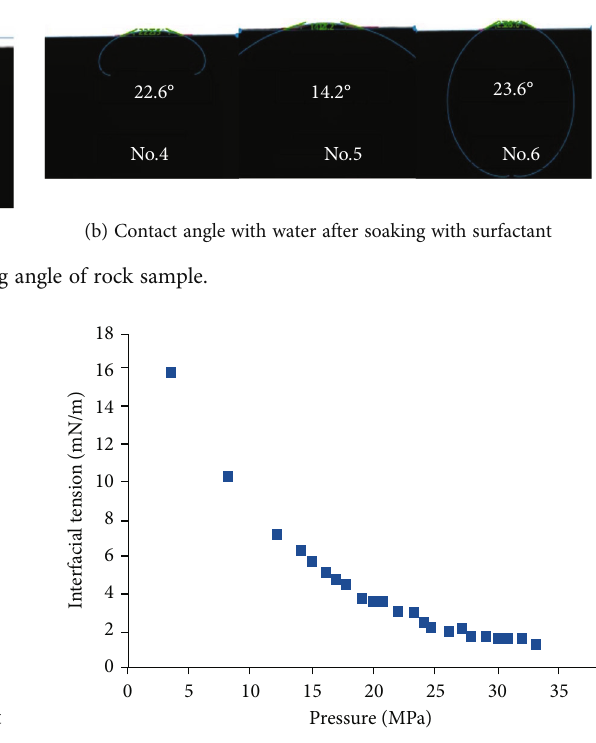
Figure 8: Interfacial tension between CO